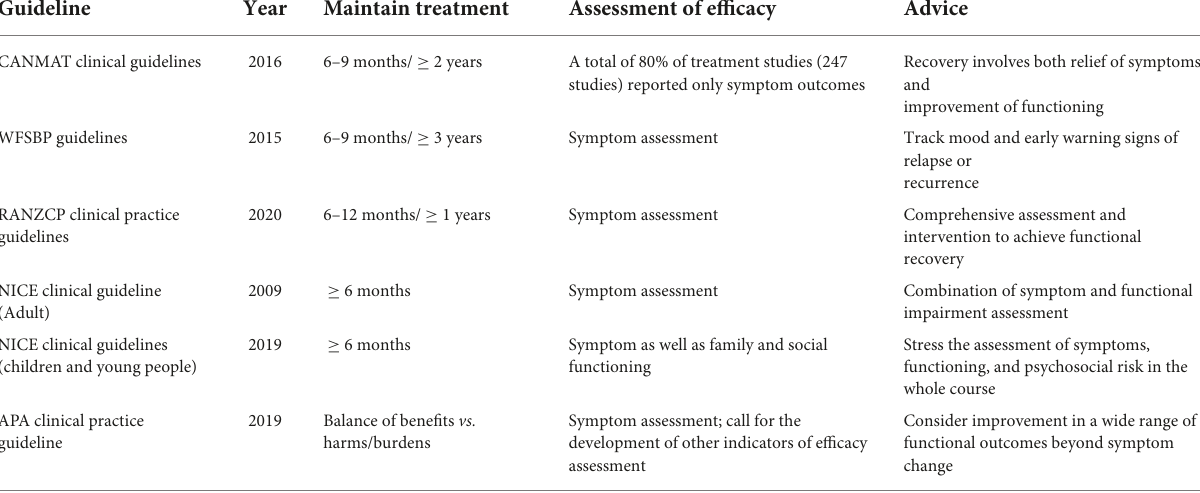
TABLE 1 Recommendations for treatment assessment from the